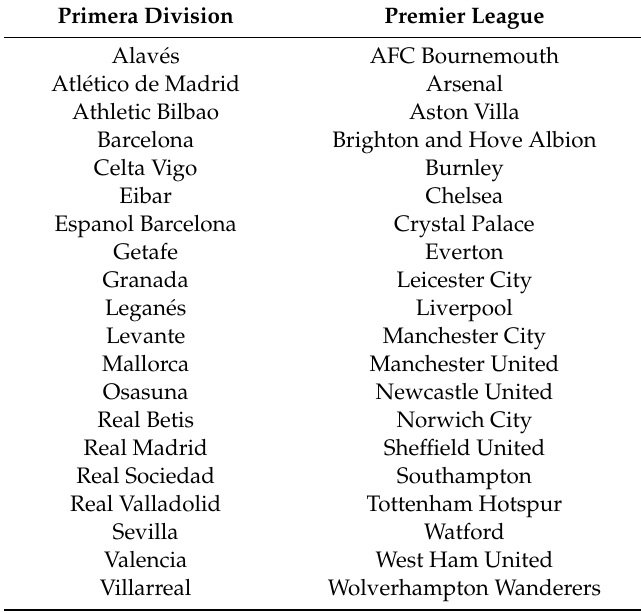
Table 1. Clubs in the Premier League and Primera Divisi ó n in the 2018 / 2019